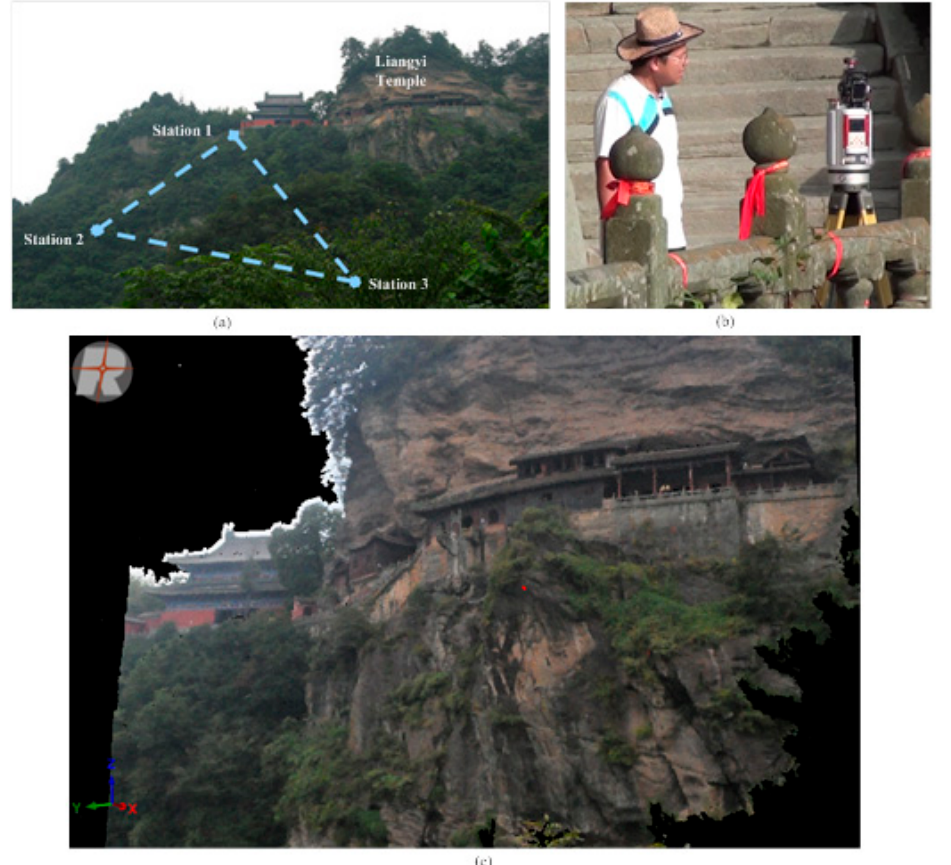
Figure 5. Long-distance laser scanner was used to acquire 3D data of the cliff terrain, and the scanning stations were located throughout the whole building ( a ); ( b ) scanning work scene on the platform; ( c ) 3D point cloud data with color information. ( c ) 3D point cloud data with color